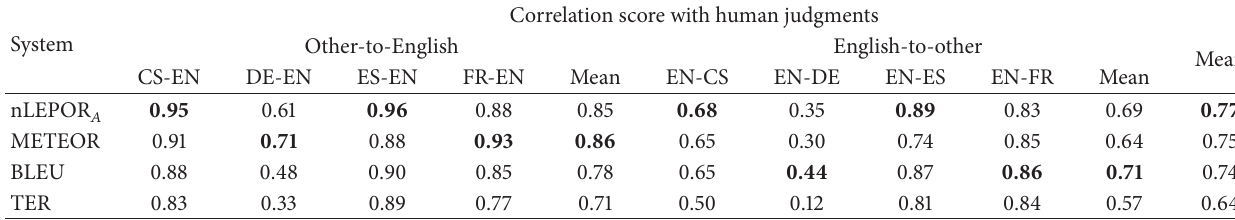
Table 4: The performances on WMT11 training corpora using Spearman correlation.